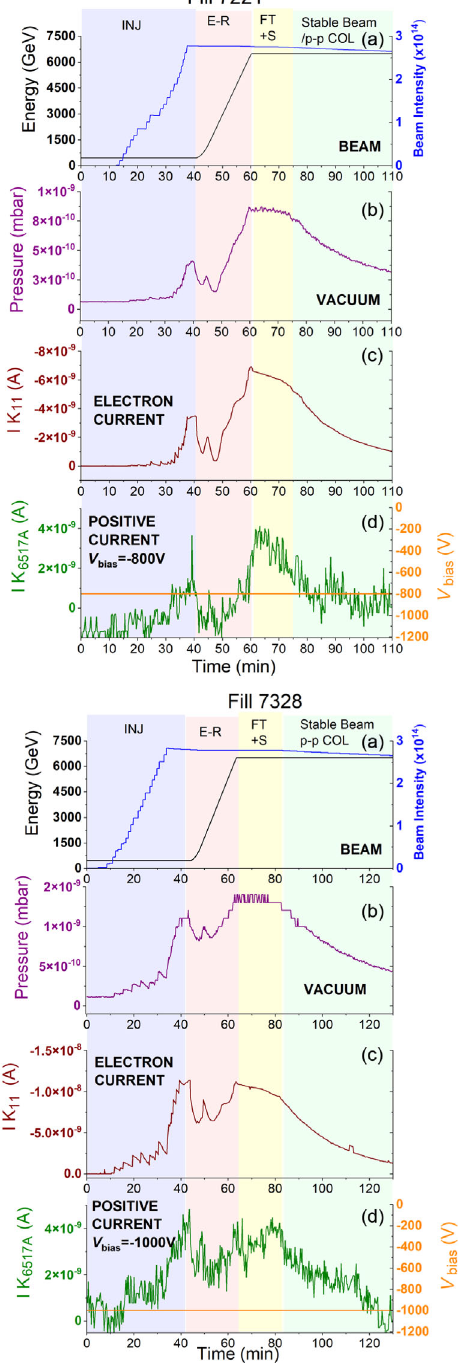
FIG. 8. Measurements performed in station 4 of the VPS during fills 7221 and 7328. Beam 1 parameters (a), pressure (b), electron current (c), positive current (d); (INJ ¼ injection, E-R ¼ Energy, Ramp, FT þ S ¼ Flat, Top, and